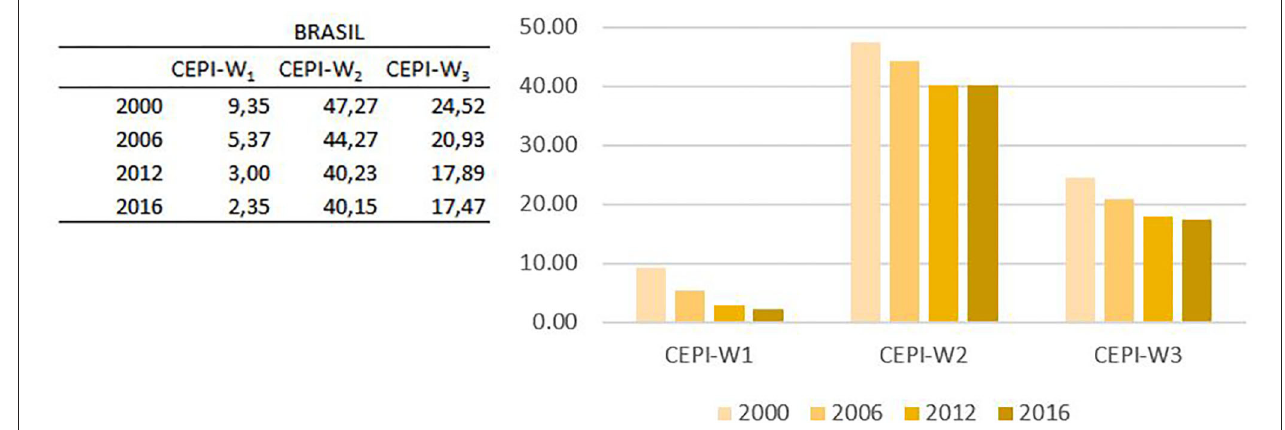
FIGURE 6 | CEPI — Brazil (2000, 2006, 2012, 2016).